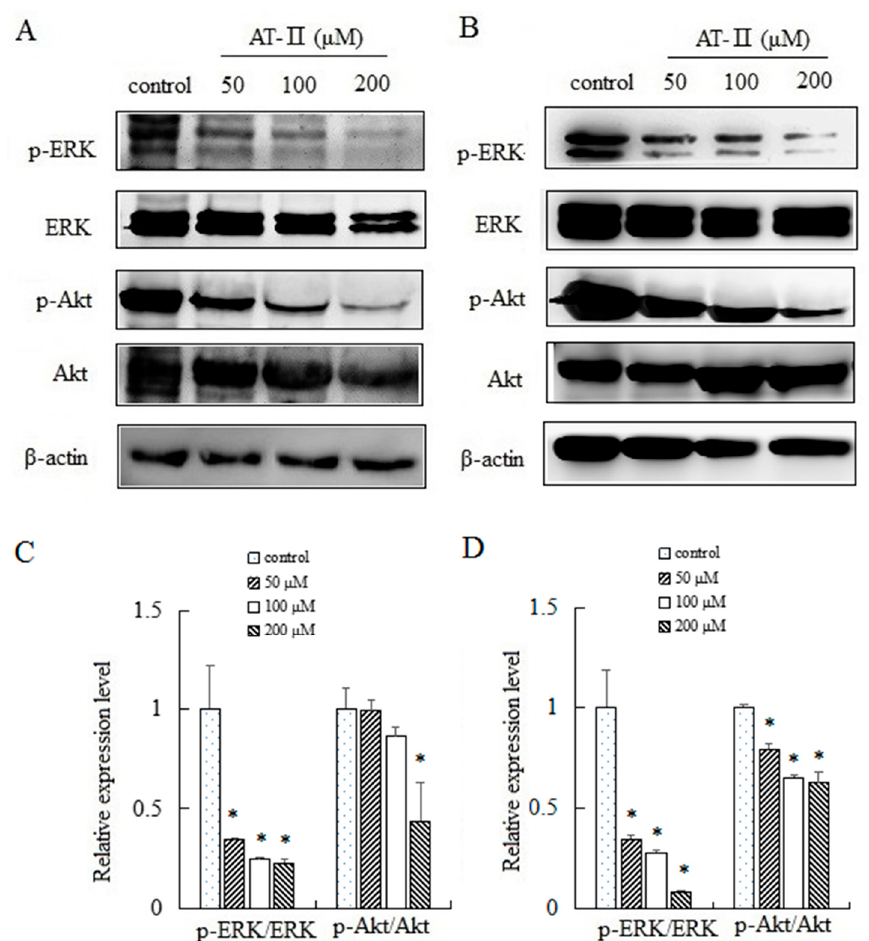
Figure 6. Expression levels of ERK, p-ERK, Akt and p-Akt in HGC-27 and AGS cells. ( A ) HGC-27 cells; ( B ) AGS cells; ( C ) relative expression levels of p-ERK/ERK and p-Akt/Akt in HGC-27 cells; ( D ) relative expression levels of p-ERK/ERK and p-Akt/Akt in AGS cells. * p < 0.05 vs. control group.